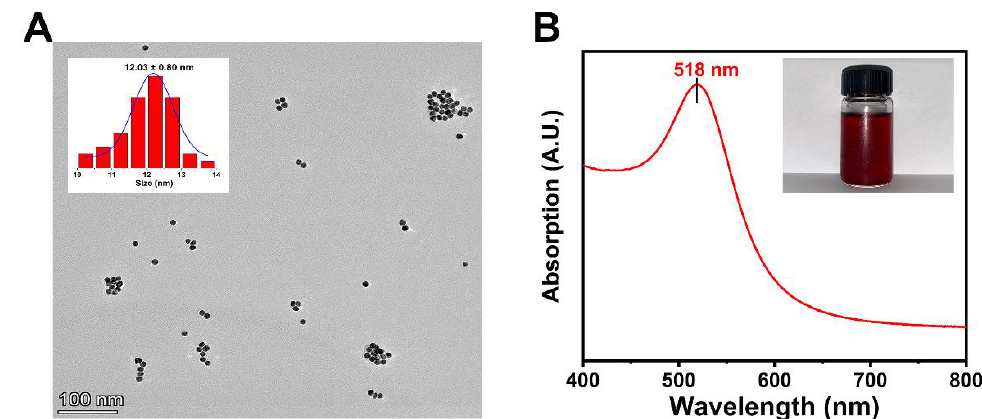
Figure 1. ( A ) The representative TEM micrograph of the AuNPs where the inset shows the histogram of the corresponding size distribution histogram. ( B ) The UV–Vis absorption spectra of AuNPs where the inset shows the representative image of AuNPs aqueous colloids.